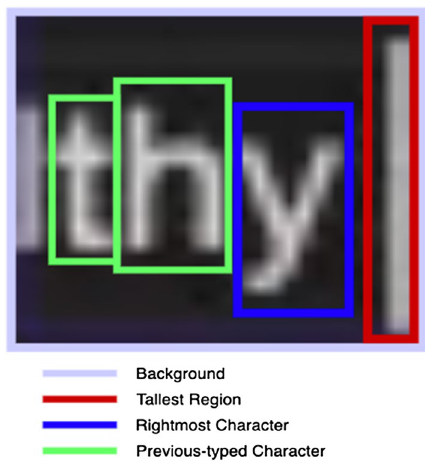
Fig. 4 Region segmentation in an isolation bounding box